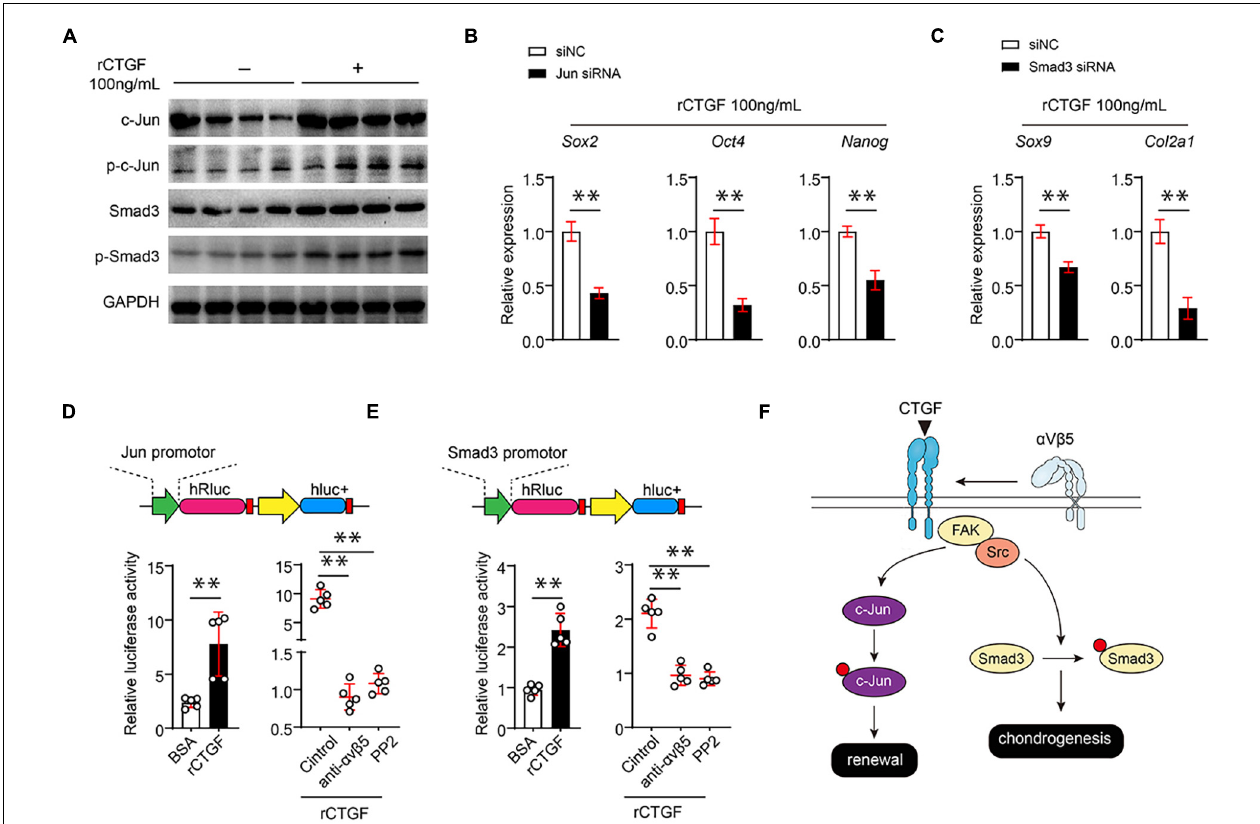
FIGURE 6 | CTGF directly induces the transcriptional activity of c-Jun and Smad3 α V β 5-FAK/Src axis. (A) Representative images of western blot of c-Jun, p-c-Jun, Smad3, and p-Smad3 of PSCs treated with or without rCTGF. (B) Quantitative PCR analysis of Sox2 , Oct4 , and Nanog of PSCs treated with rCTGF with or without c-Jun siRNA. (C) Quantitative PCR analysis of Sox9 and Col2a1 after rCTGF treatment with or without Smad3 siRNA. (D,E) The 1,000 bp upstream of the Jun transcription start site (TSE) was cloned in front of the firefly luciferin expression gene (hRluc). rCTGF was added to study its effect on the transcription of Jun and Smad3. At the same time, α V β 5 neutralizing antibody and Src inhibitor PP1 were used to study the effect of α V β 5-FAK/Src axis on the transcription of Jun and Smad3 by rCTGF. The ratio of hRluc to hluc were detected for quantitative statistics. (F) Data are shown as mean ± SD. ∗∗ P <